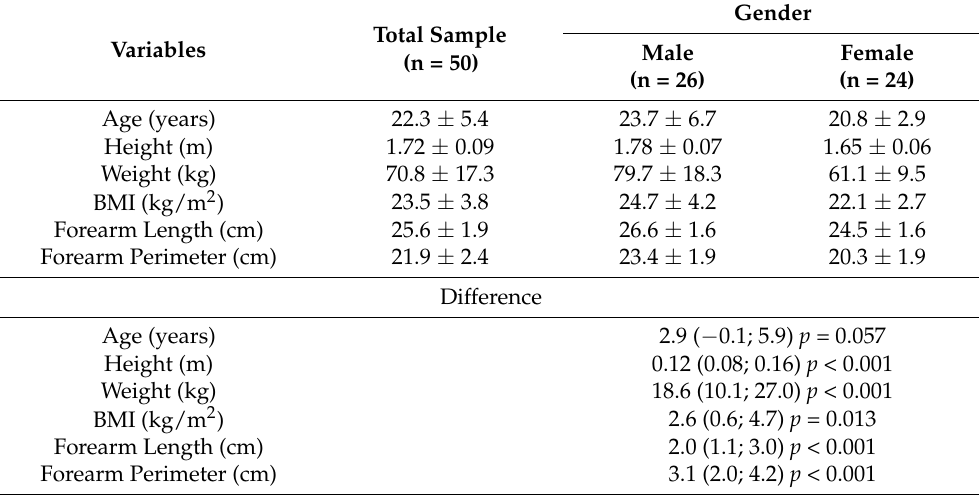
Table 1. Participants’ demographic and anthropometric characteristics by gender.